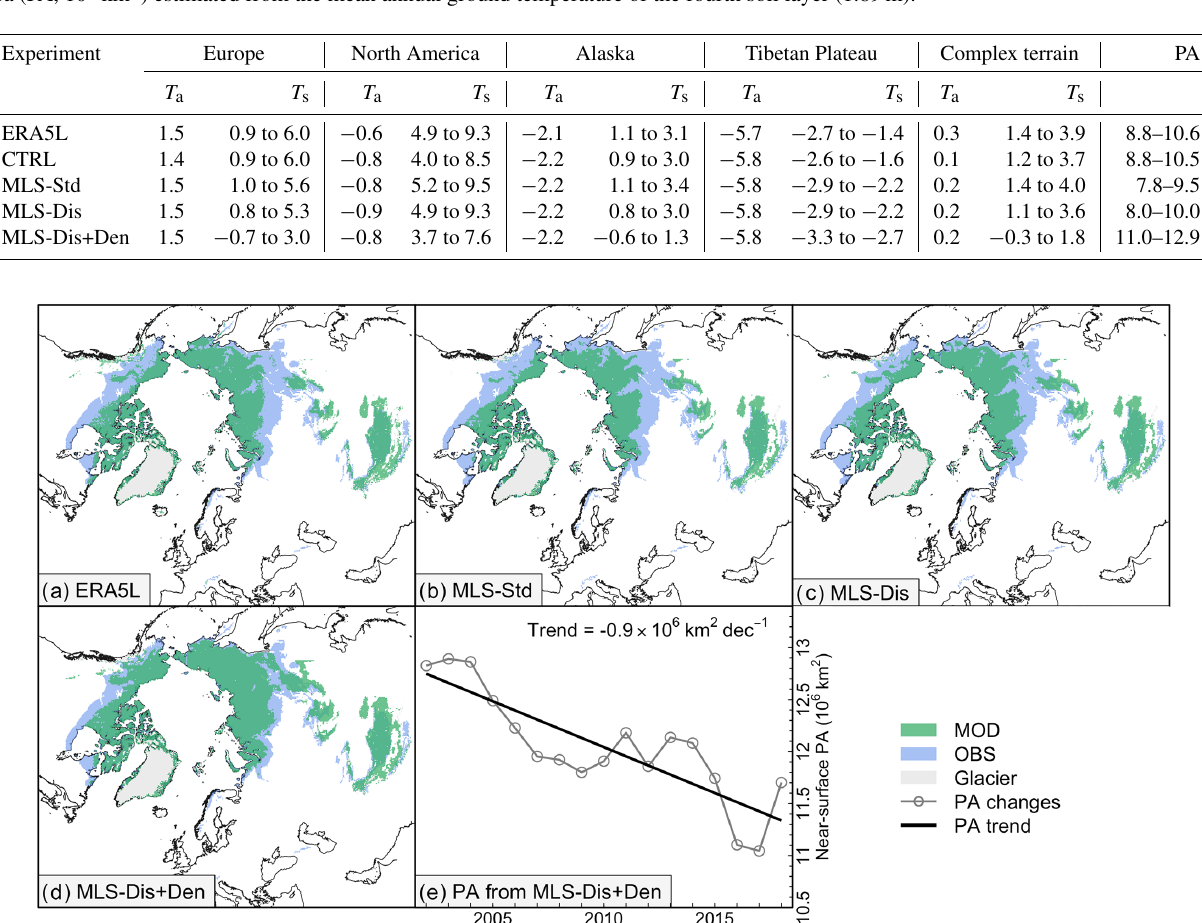
Figure 3. Observed estimates for continuous and discontinuous permafrost area (PA) from the IPA map (OBS) and near-surface permafrost area derived from HTESSEL with different model schemes (MOD) in 2001–2002. The near-surface permafrost area trend (E) is derived from the Exp. MLS-Dis+Den during